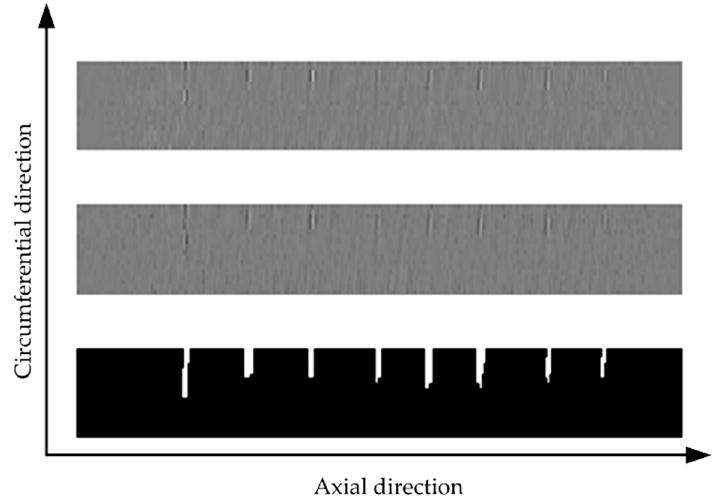
Figure 10. Raw down-sampling gray image ( top ); sharpened defect image ( middle ); and defect location image ( bottom ). In the first location were two defects along the circumference with one and two broken wires.